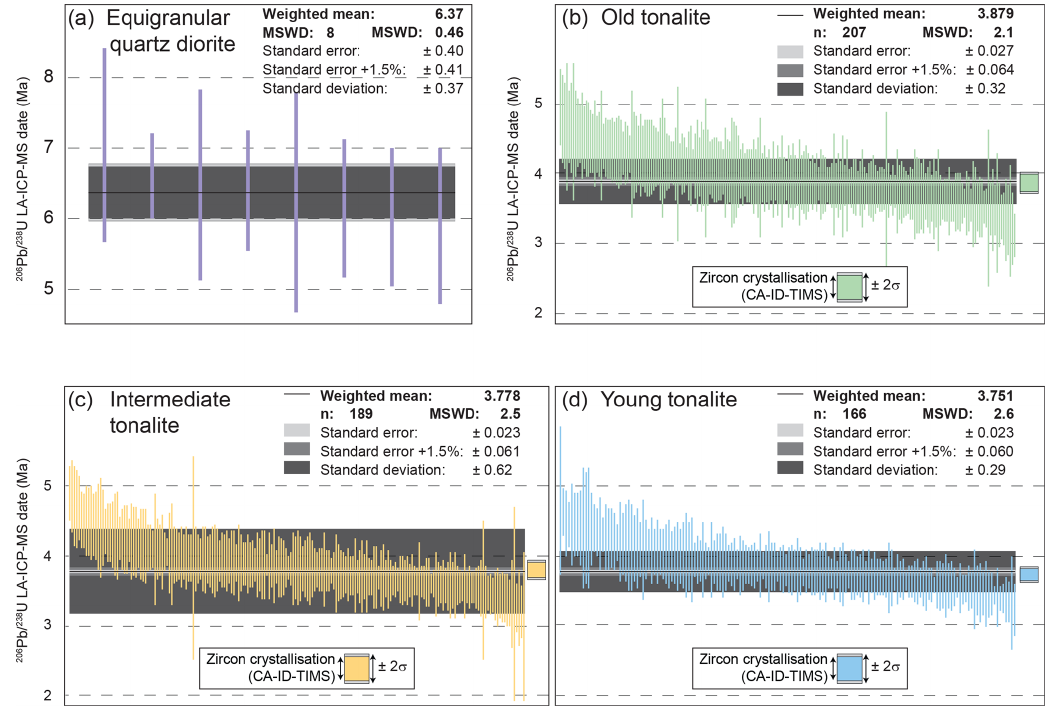
Figure 7. In situ U–Pb geochronology by LA-ICP-MS of zircons from the equigranular quartz diorite (a) , the old tonalite (b) , the intermediate tonalite (c) and the young tonalite (d) . Vertical lines illustrate individual U–Pb dates including analytical uncertainty (2 σ ). As no zircon populations can be separated, the weighted mean average of all analyses is calculated. Standard error (2SE, lightest grey), standard error + 1 . 5% (light grey) to incorporate excess variance (Horstwood et al., 2016) and standard deviation of all individual dates (dark grey) are calculated and plotted. Duration of zircon crystallisation as obtained by CA–ID–TIMS is illustrated as a box for comparison. Lower boundary of the coloured box indicates youngest CA–ID–TIMS date or the emplacement age. Note the different vertical scale in panel (a) . Zircon dates from the equigranular quartz diorite are ∼ 2Myr older than zircons from the